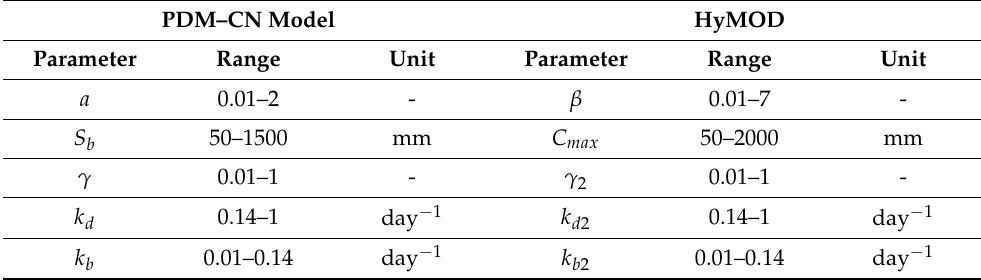
Figure 1. The structure of the proposed PDM–CN model which unifies the PDM (probability dis ‐ tributed model) and the SCS curve number method. Table 1. The ranges of parameters for the proposed PDM–CN model and HyMOD model. Table 1. The ranges of parameters for the proposed PDM–CN model and HyMOD